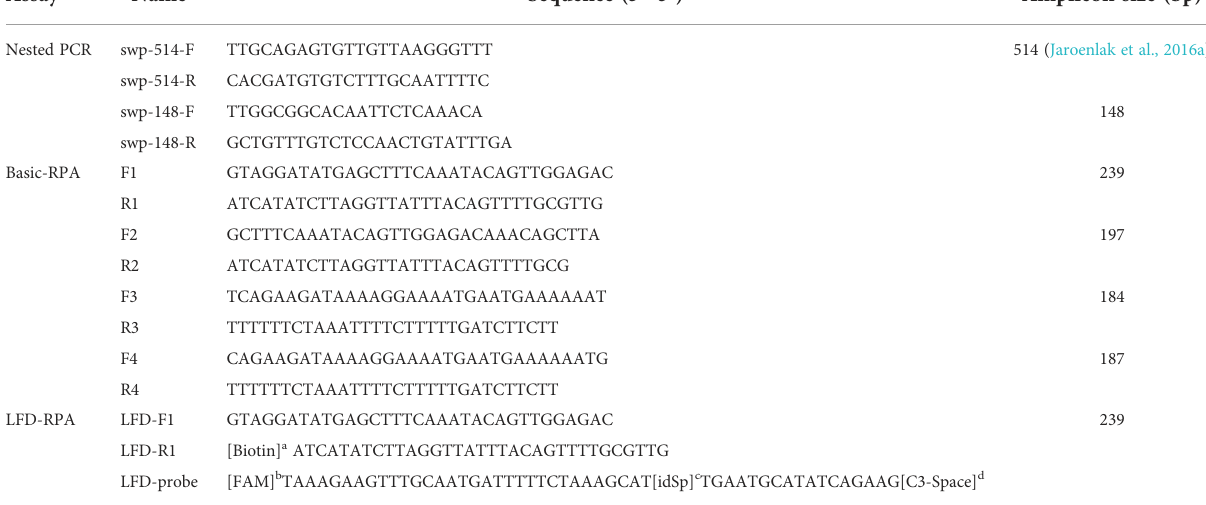
TABLE 1 Primers and probes used in this study.